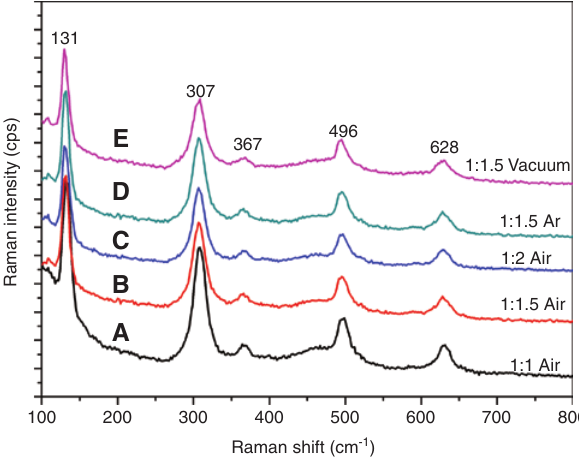
O prepared by annealing in air with 2 3